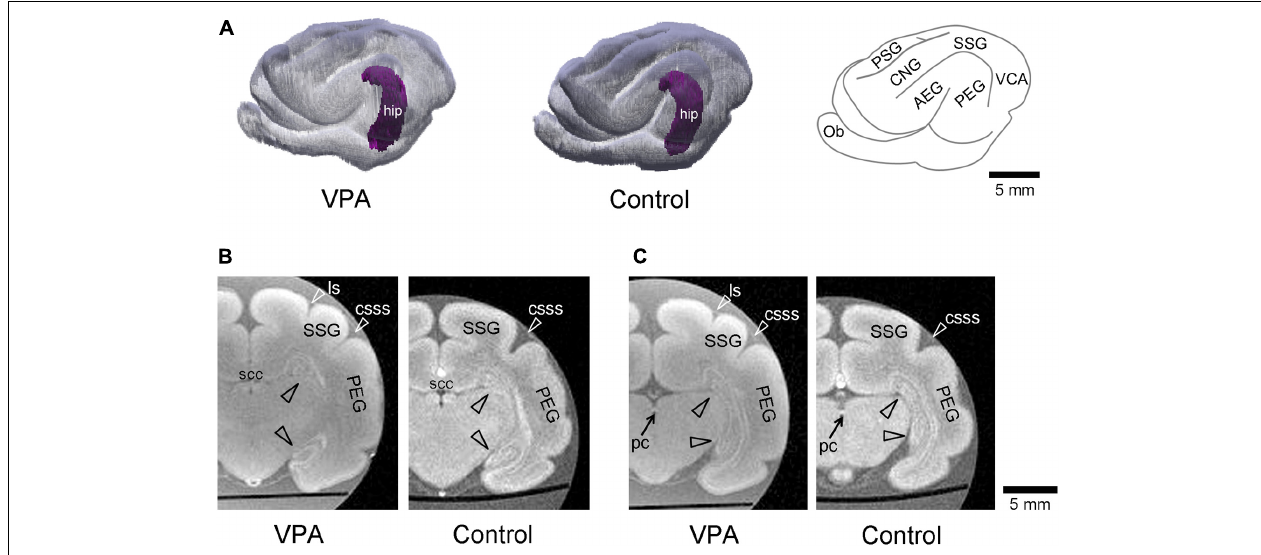
FIGURE 1 | Three-dimensional volume-rendered images in cerebrum with the hippocampus of the postnatal day (PD) 20 ferrets. (A) The left and moderate images are reconstructed images of the cerebral cortex and hippocampus (hip; purple) of the left hemisphere in valproic acid (VPA)-treated and control ferrets, respectively. A gyral map of the left hemisphere is shown on the right. (B) Coronal ex vivo magnetic resonance (MR) images [using RARE sequence with short repetition time (TR) and minimum time to echo (TE) setting] of cerebrum including the hippocampus at the caudal end of the splenium of corpus callosum from VPA-treated ferret (left) and control one (right). (C) Coronal ex vivo MR images of cerebrum including the hippocampus at the posterior commissure from VPA-treated ferret (left) and control one (right). AEG, anterior ectosylvian gyrus; CNG, coronal gyrus; csss, caudal suprasylvian sulcus; Ob, olfactory bulb; ls, lateral sulcus; pc, posterior commissure; PEG, posterior ectosylvian gyrus; PSG, posterior sigmoid gyrus; scc, splenium of the corpus callosum; SSG, suprasylvian gyrus; VCA, visual cortical